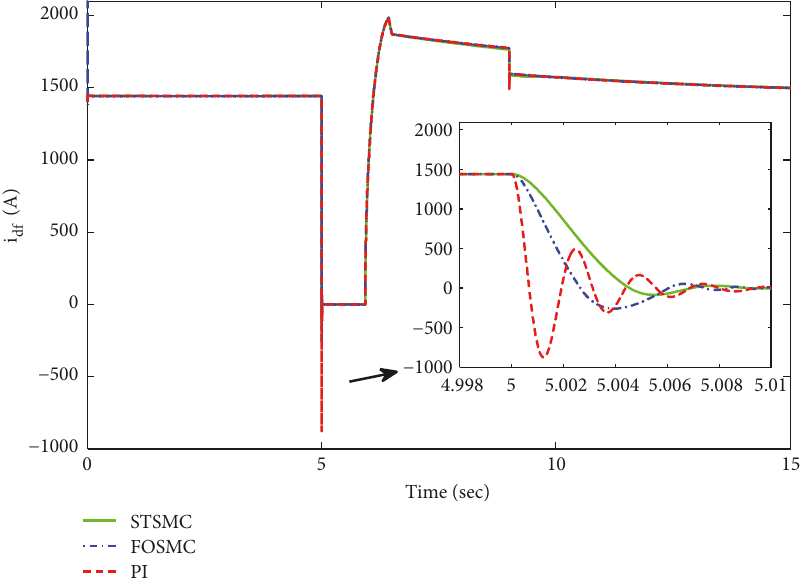
Figure 7: The d-axis current of the GSC with PI, FOSMC, and STSMC.